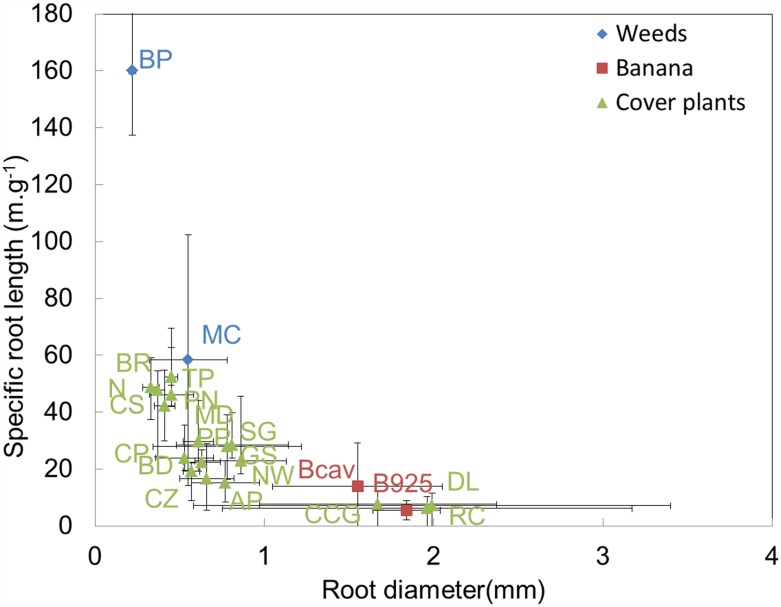
Species distributions regarding the relationship between specific root length and root diameter.See Table 2 for the species names. (n = 4 replicates for all species except BD (n = 3)).